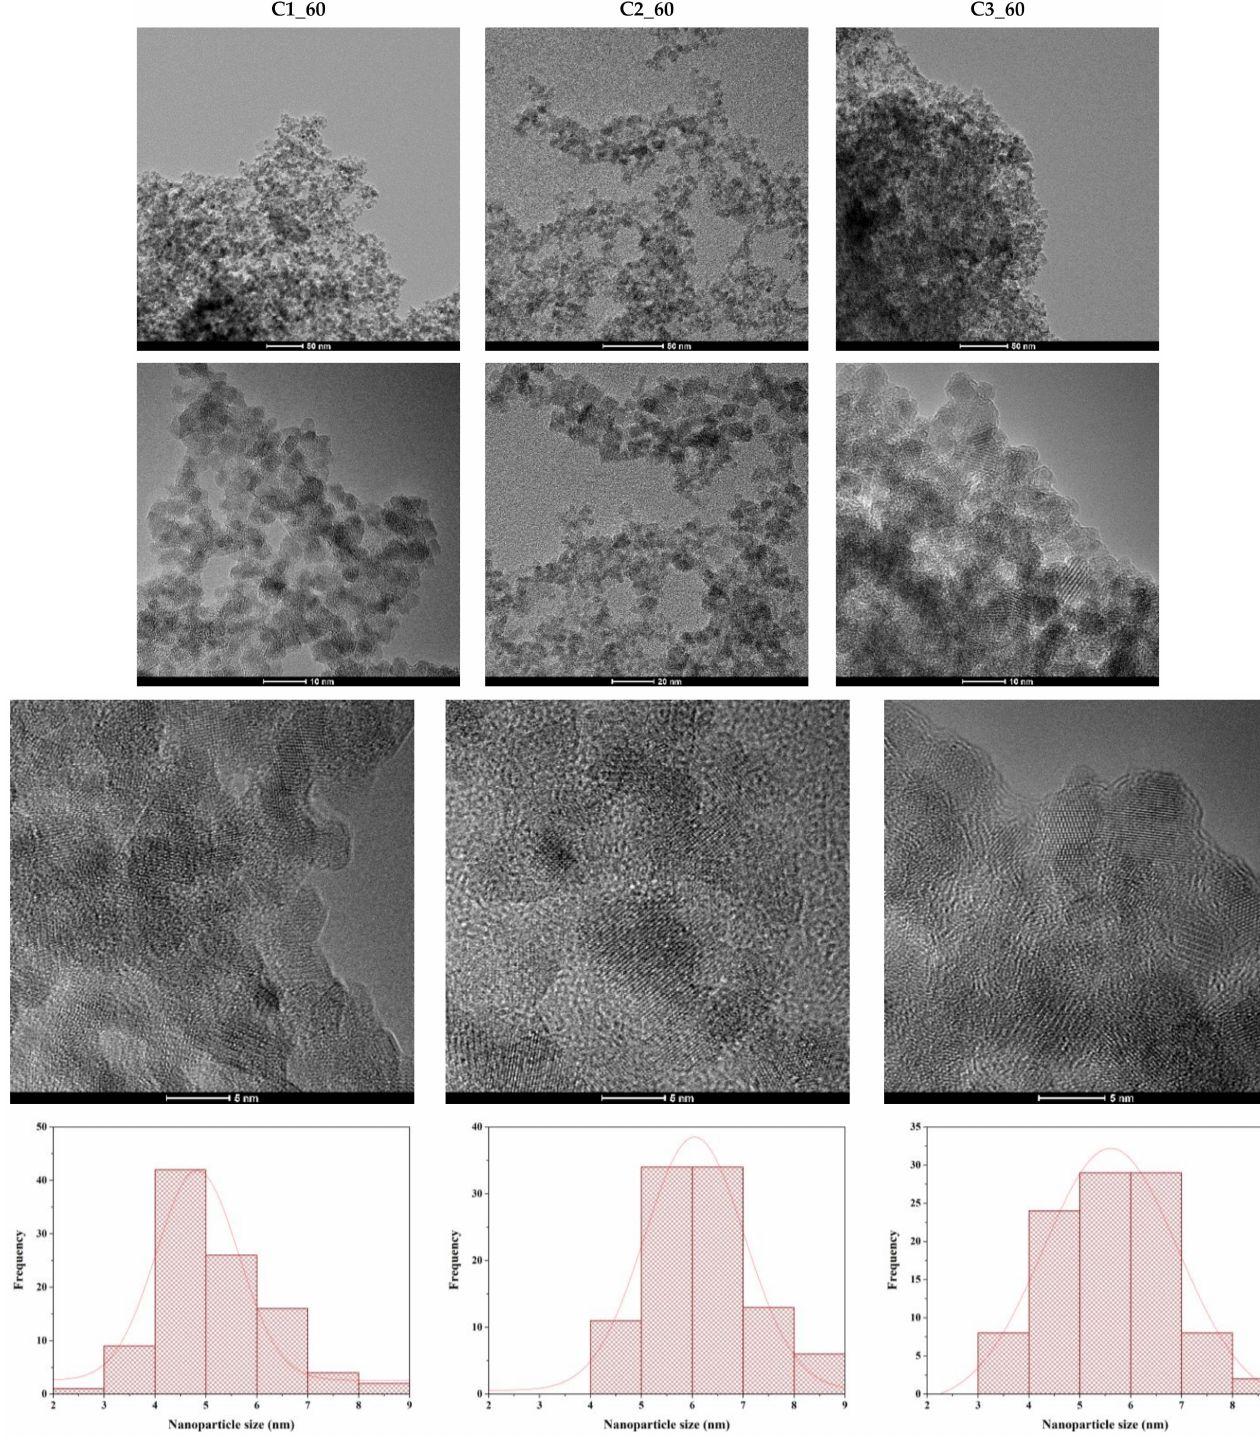
Figure 8. TEM images and the corresponding histograms for samples C1_60, C2_60, and